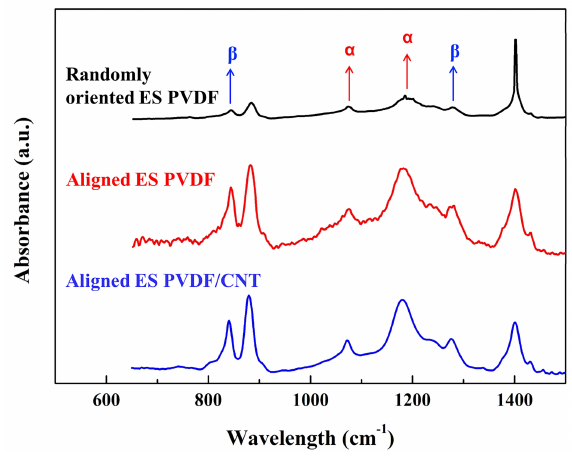
Figure 2. FTIR spectra for the PVDF samples.